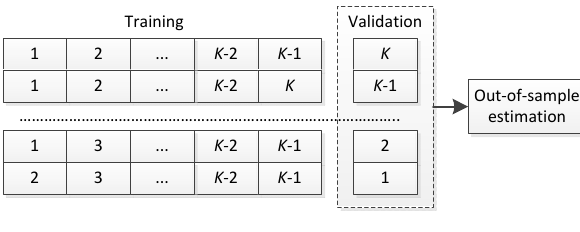
Figure 6. A K ‐ fold SCV. Figure 6. A K -fold SCV.